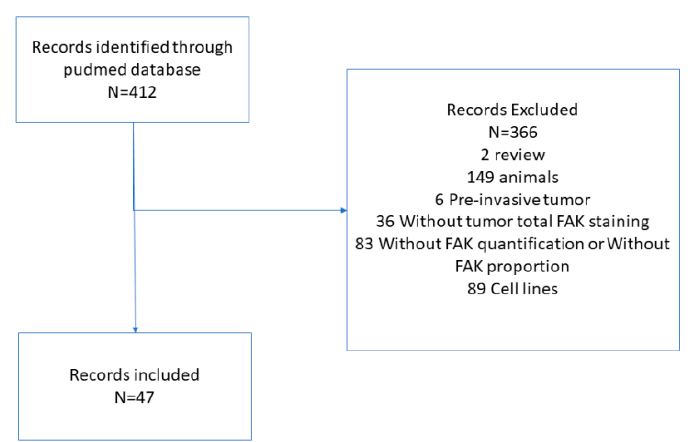
Figure A1. PRISMA guidelines for methodological review of literature related to frequency of focal adhesion kinase (FAK) overexpression at protein level in human solid cancers.